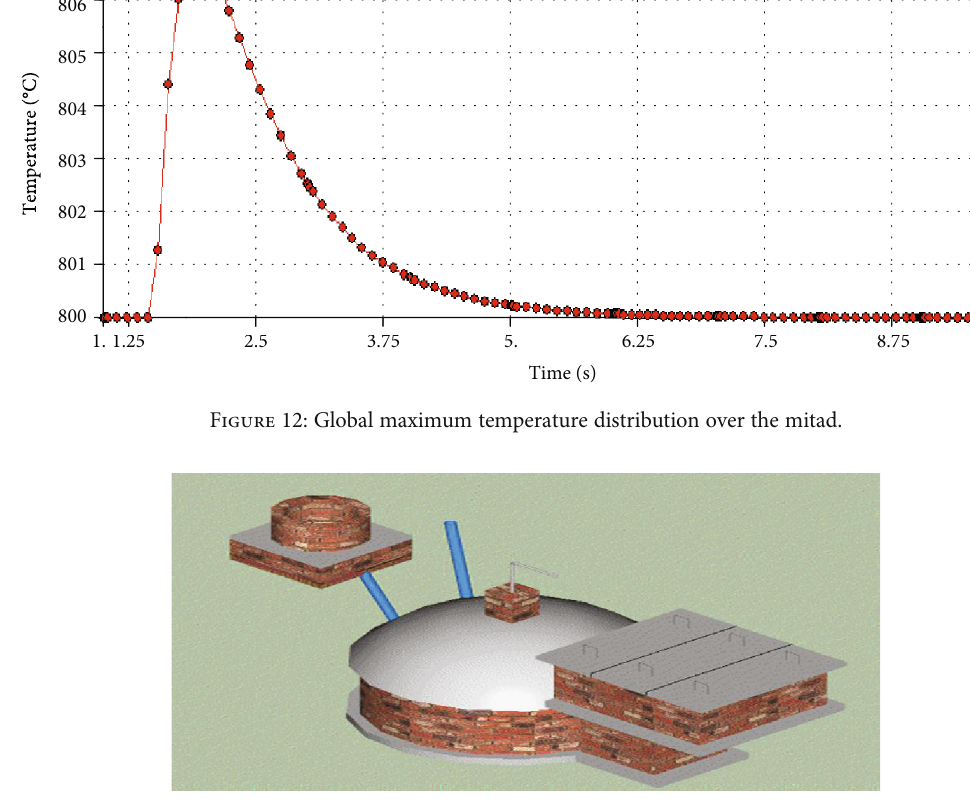
Figure 13: Biogas digester with a mixing pit and slurry